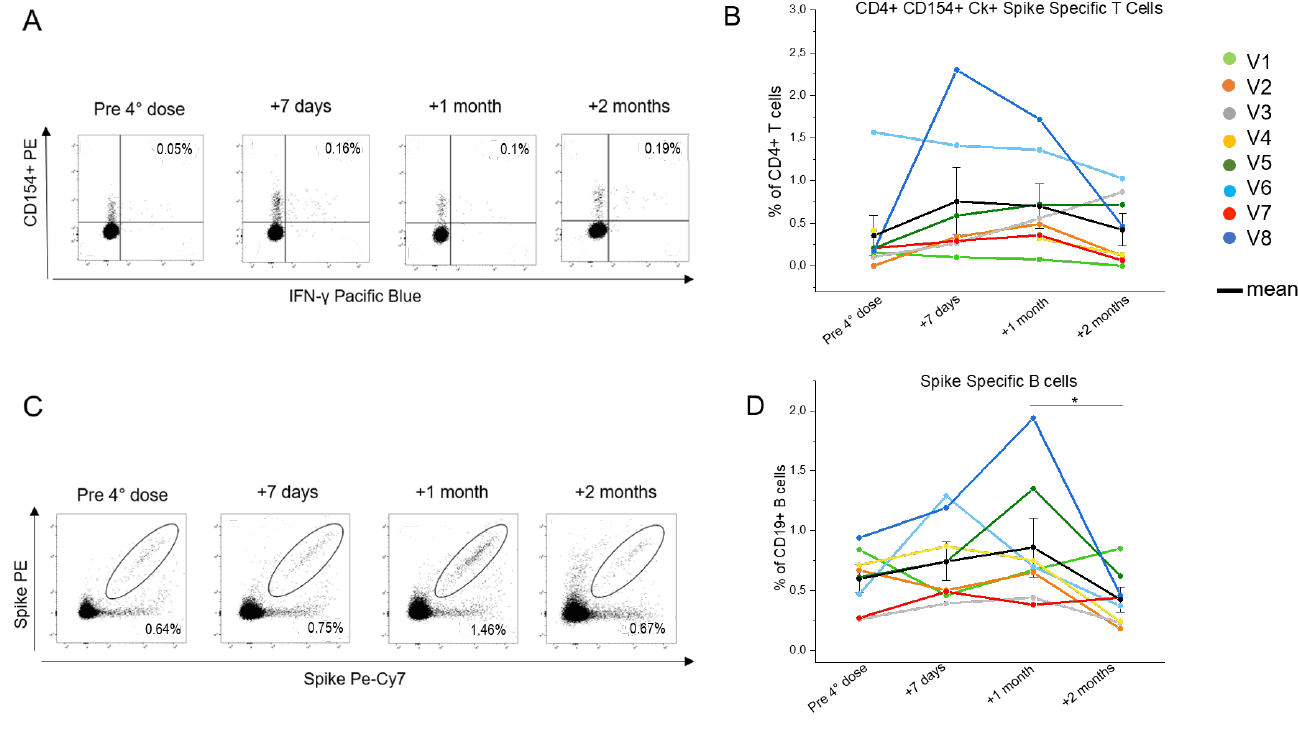
Figure 2. Evaluation of the SARS-CoV-2-specific circulating CD4+ T and B cells in eight people living with HIV (PLWH), up to 2 months after the fourth vaccine dose . ( A ) Representative flow cytometric plots of the spike-specific CD154+CD4+IFN- γ + T cells in one selected individual living with HIV. ( B ) Kinetic analysis of the frequencies of the CD154+CD4+ T cells producing at least one cytokine among IL-2, IFN- γ , and TNF- α in eight PLWH before, one week, one month, and two months after the fourth vaccine dose. Each color corresponds to a different subject. The T cell evaluation of subject V4 lacks the +7 days timepoint. Black dots indicate mean values. ( C ) Representative flow cytometric plots of the spike-specific B cells in one selected individual living with HIV. ( D ) Kinetic analysis of the frequencies of the spike-specific B cells in eight PLWH before, one week, one month, and two months after the fourth vaccine dose. Each color corresponds to a different subject. Black dots indicate mean values * p ≤ 0.05. Error bars indicate SE values.